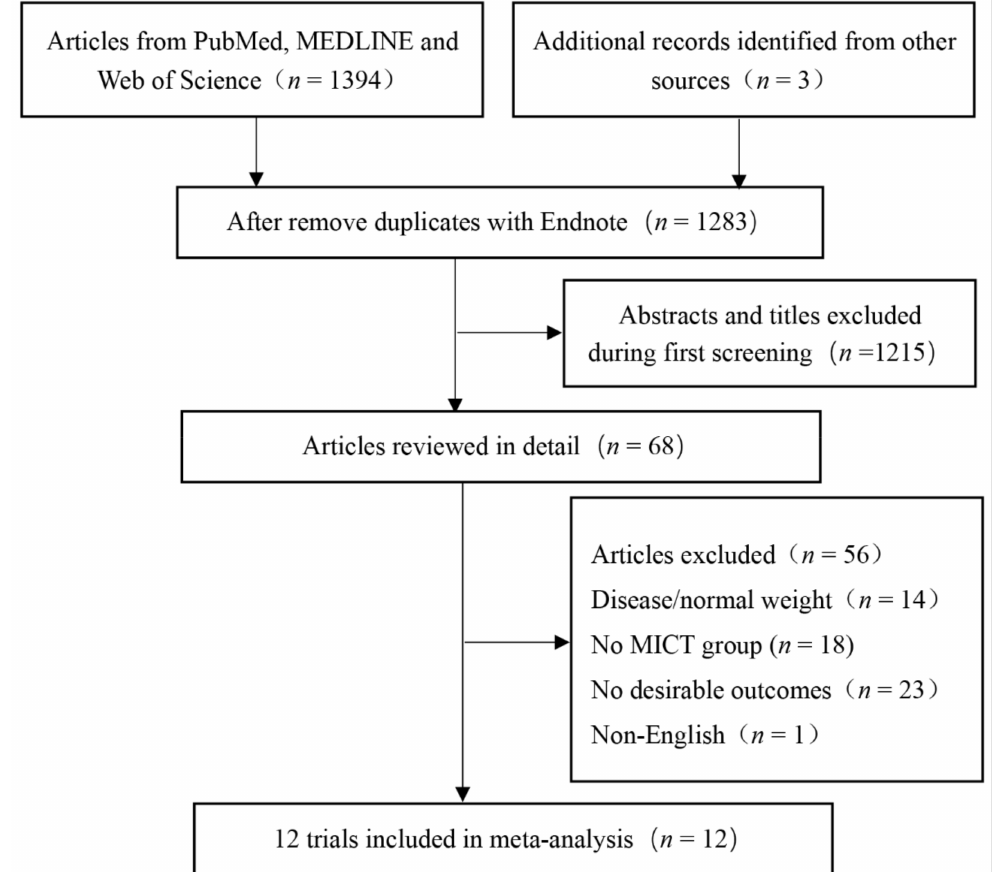
Figure 1. Flow diagram of the study selection. MICT: moderate-intensity continuous